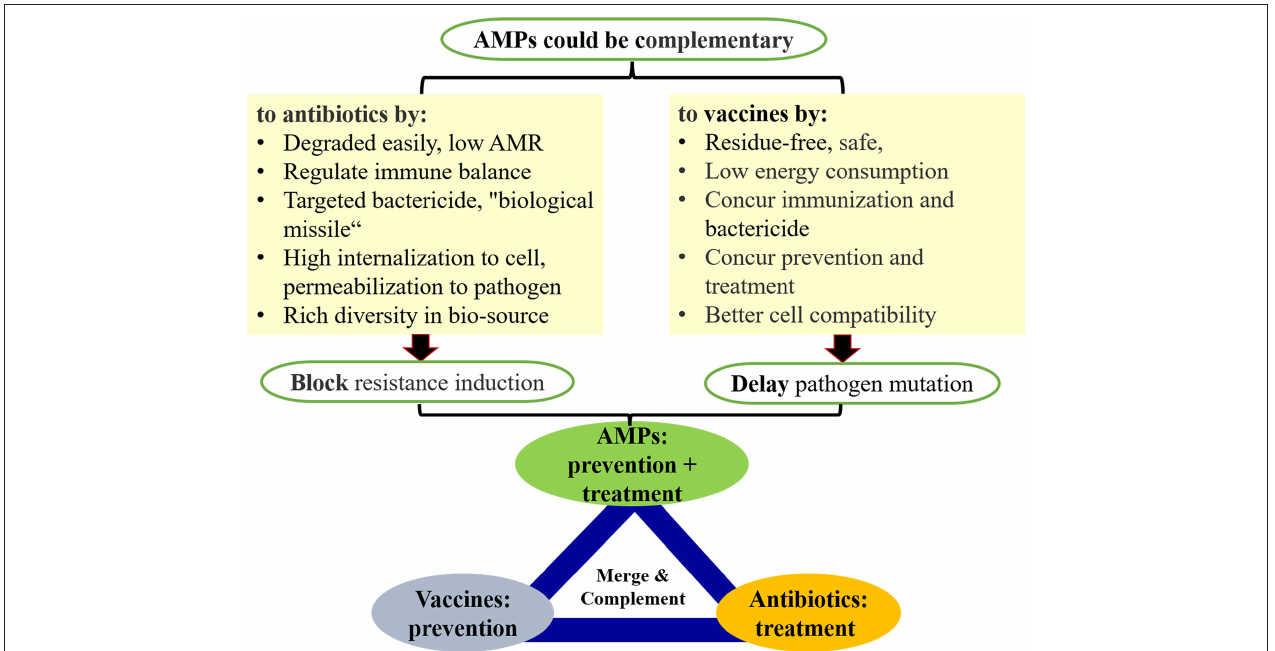
FIGURE 1 | An iron triangle of health protection from AMPs, antibiotics and vaccines for maintaining a reasonable equilibrium among pathogens, antimicrobials and drug resistances is important and essential for one health management at safety level ( Hao et al., 2017; Wang et al., 2018, 2022; Liu et al., 2021a; Zheng et al.,